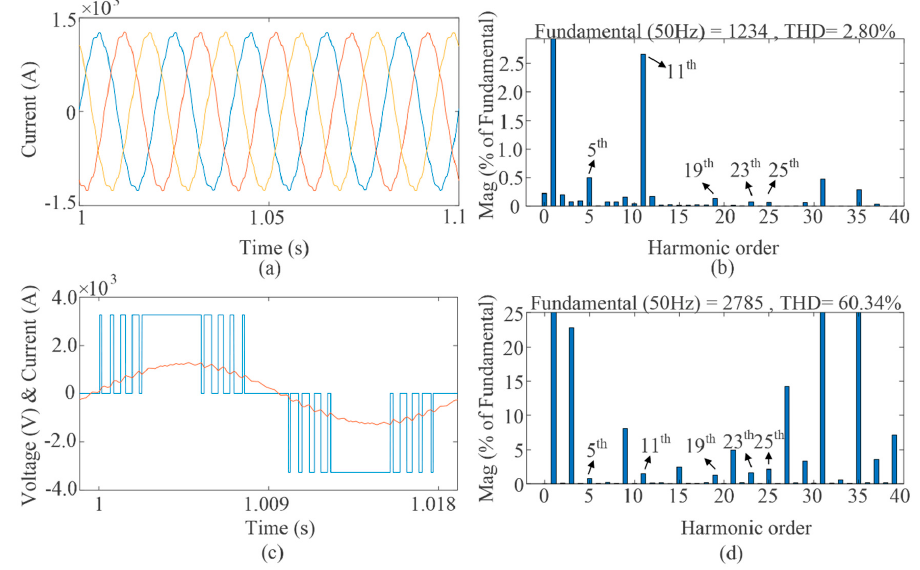
Figure 18. Line currents ( a ), the THD analysis of phase A current ( b ), detailed bridge arm voltage and current ( c ), and the THD analysis of the bridge arm voltage ( d ), under dead time of 10 µ s inserted SHE-PWM modulation.